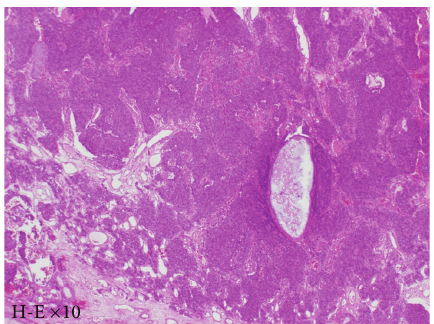
Figure 7: Pathological findings in case 2. Hematoxylin-eosin stains showed a nest-like tumor mass under the mucosa. The tumor cells showed monotonous growth. Based on slight anisokaryosis and mitotic figures, the tumor was diagnosed as an ONB, Hyams’s stage